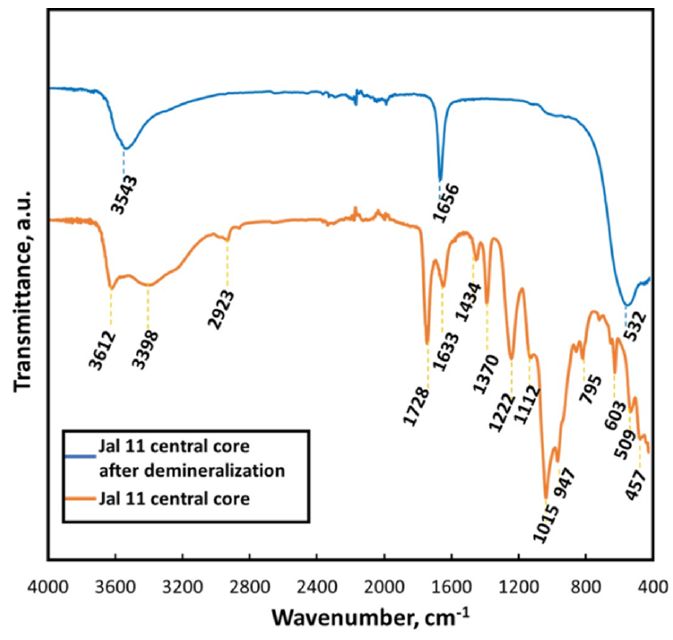
Figure 20. Attenuated total reflectance Fourier transform infrared spectroscopy (ATR-FTIR) spectra of the central filamentous core from sample Jal 11 before (orange line) and after (blue line) demineralization following treatment with 10% hydrofluoric acid (HF) over 4 days.